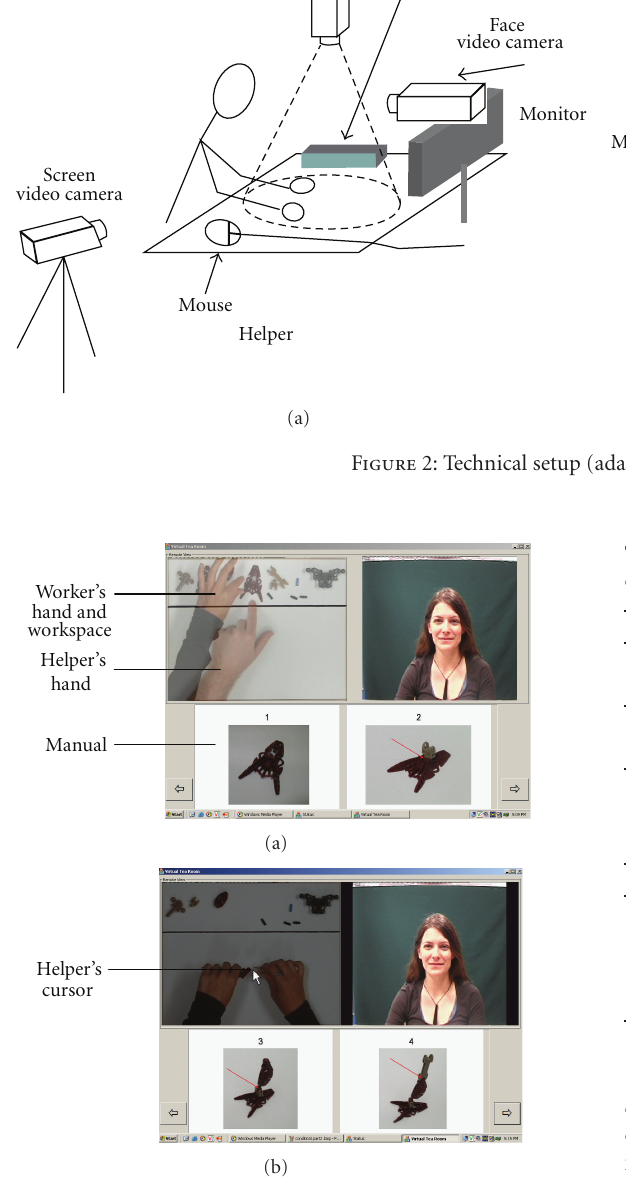
Figure 3: Helper’s view, in hand’s (a) and cursor pointer condition (b). (Note: the worker’s view was similar in each condition, with the exception that the manual on the bottom of the screen was not visible).